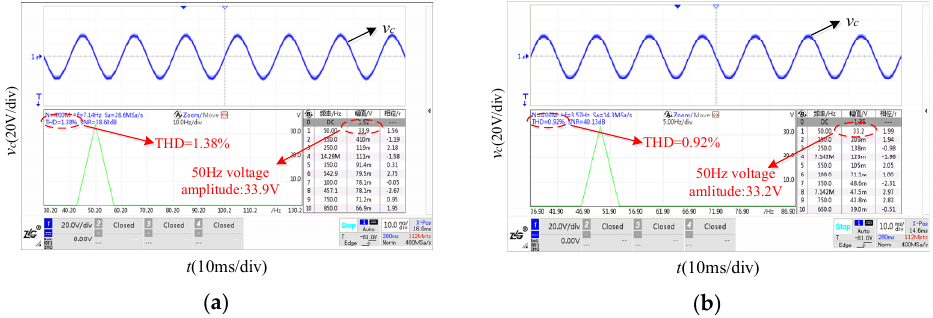
Figure 14. FFT Analysis of v c : ( a ) traditional modulation strategy; ( b ) improved modulation strategy.